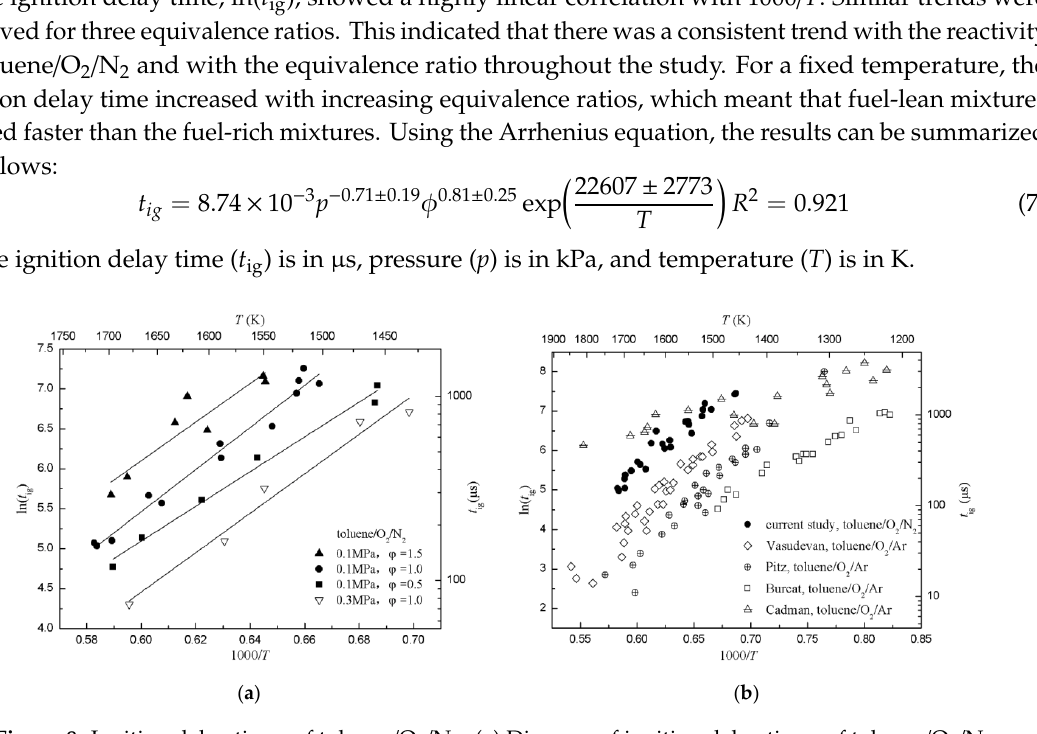
Figure 8. Ignition delay times of toluene/O 2 /N 2 . ( a ) Diagram of ignition delay times of toluene/O 2 /N 2 and fitted curves with pressures of 0.1–0.3 MPa, temperatures of 1432–1716 K, and equivalence ratios of 0.5–1.5; ( b ) previously published data [7,25–27] is provided for comparison, normalized to a pressure of 0.1 MPa and an equivalence ratio of